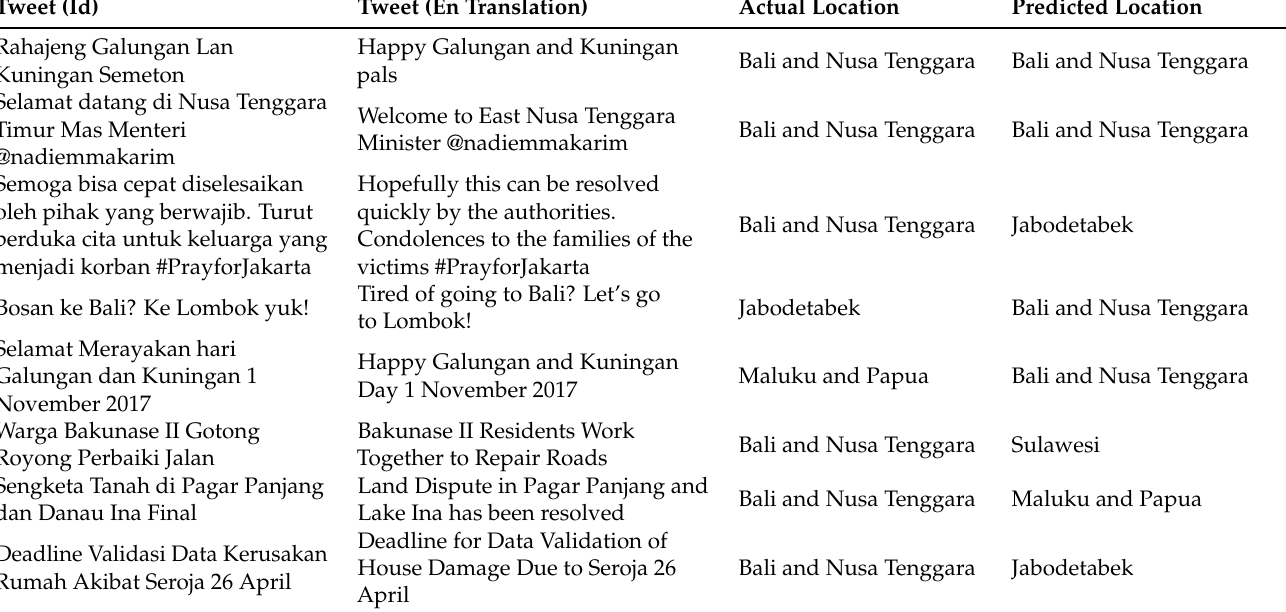
Table 6. The example of location prediction results of tweet with